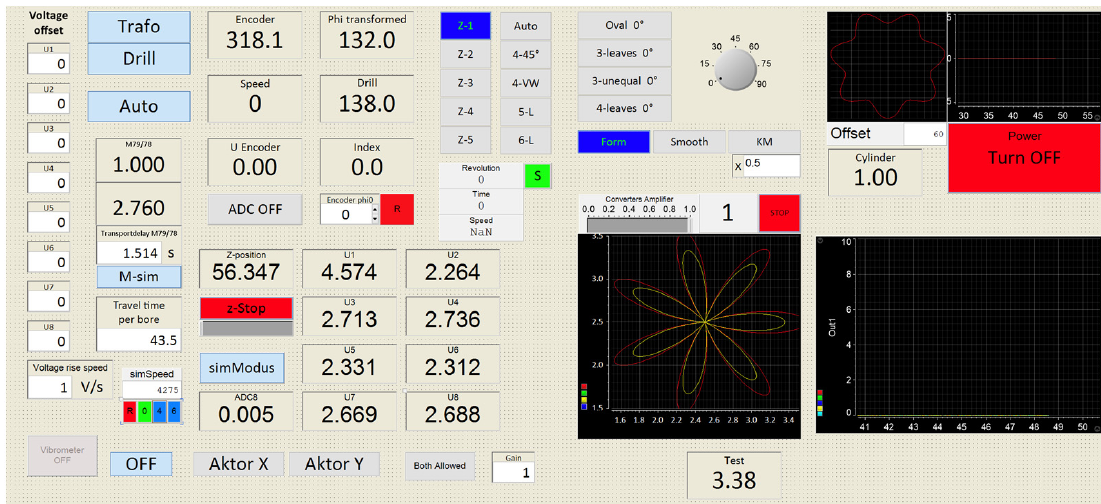
Figure 8. Process control in dSpace ControlDesk.